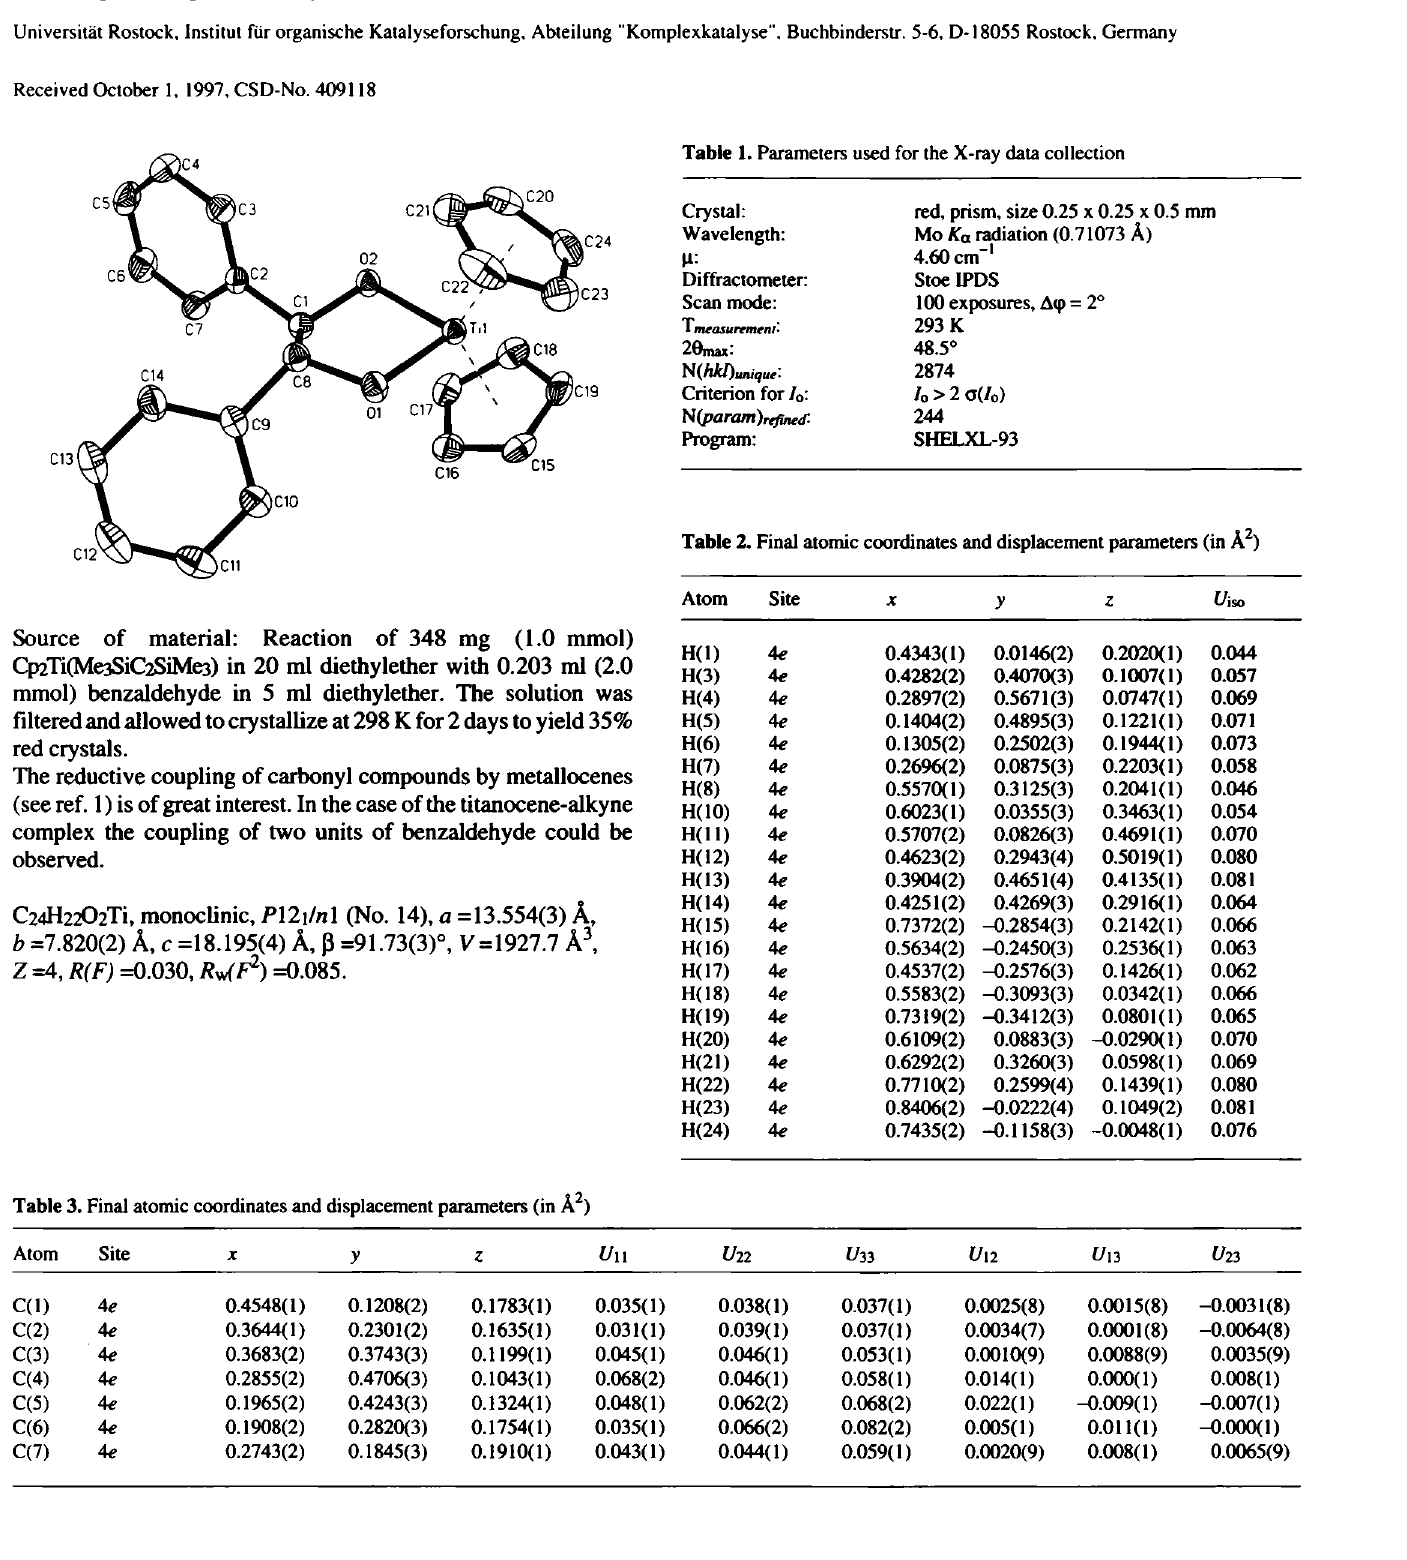
Table 3. Final atomic coordinates and displacement parameters (in Â^)